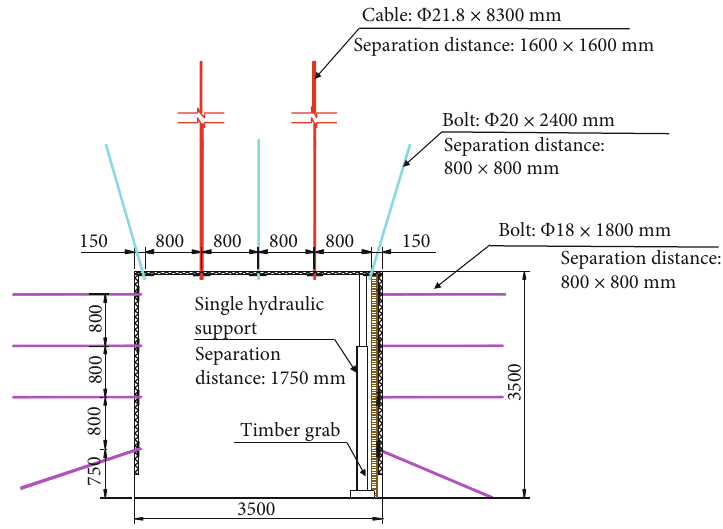
Figure 16: Support scheme for withdrawal